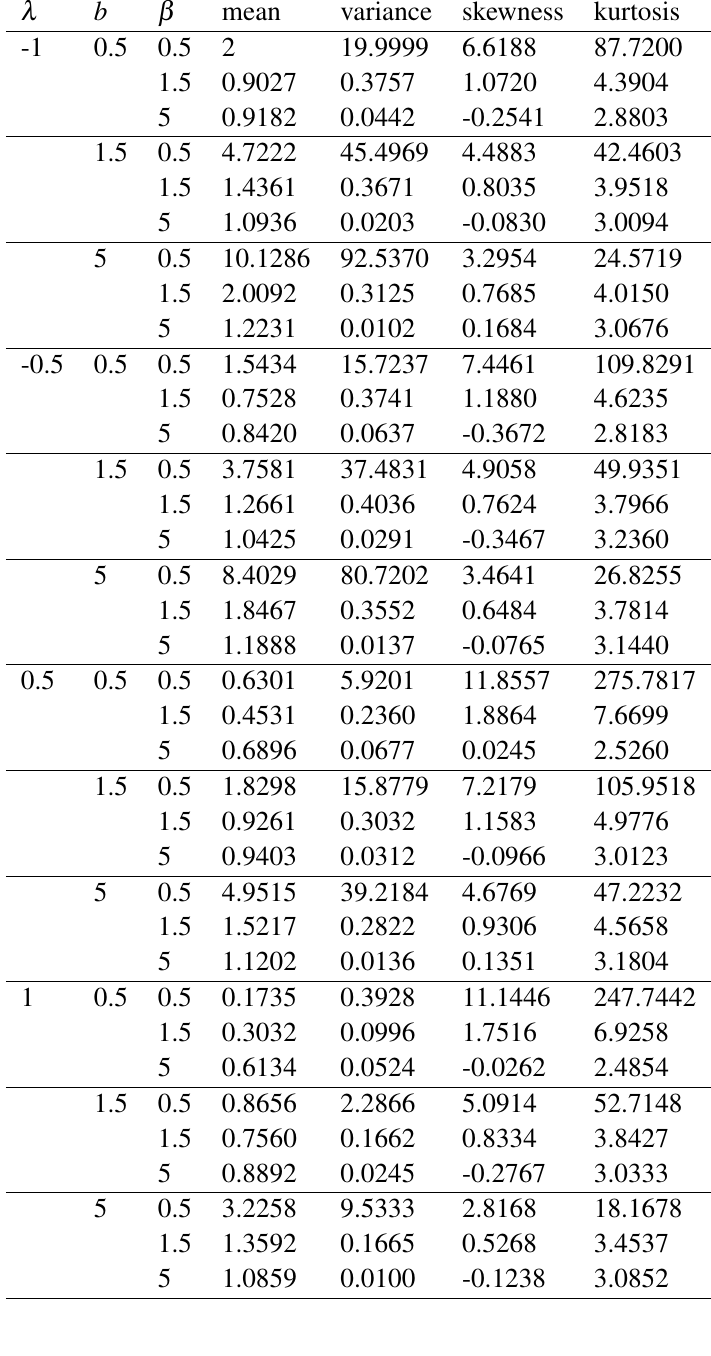
Table 2. Mean, variance, skewness and kurtosis for selected parameter